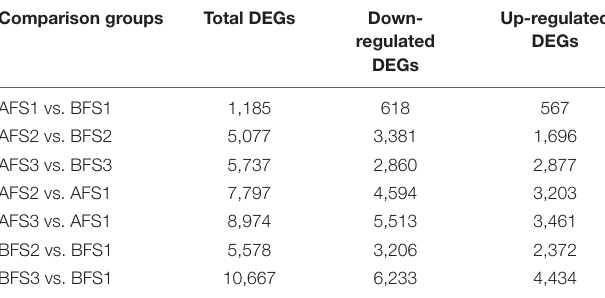
TABLE 2 | DEGs statistics in the fruits of two oriental melon